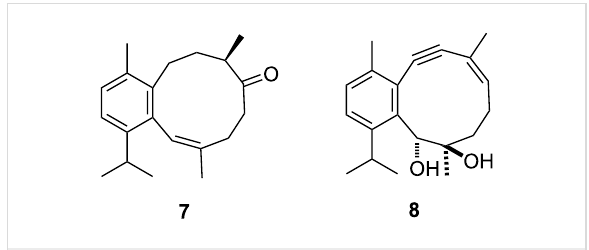
Figure 2: Synthetic eunicellane-type compounds with benzene partial